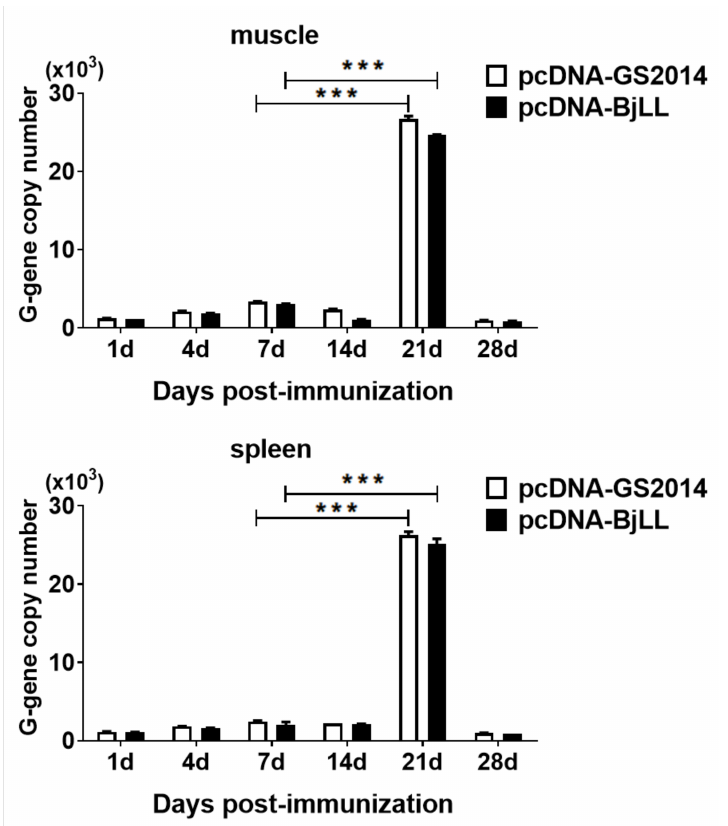
Figure 5. Expression of G gene postvaccination. The G gene expression in spleen and muscles of the injection site at days 1, 4, 7, 14, 21, and 28 after immunization were measured by RT-qPCR. Graphs are shown from three independent replicates (*** p < 0.001).